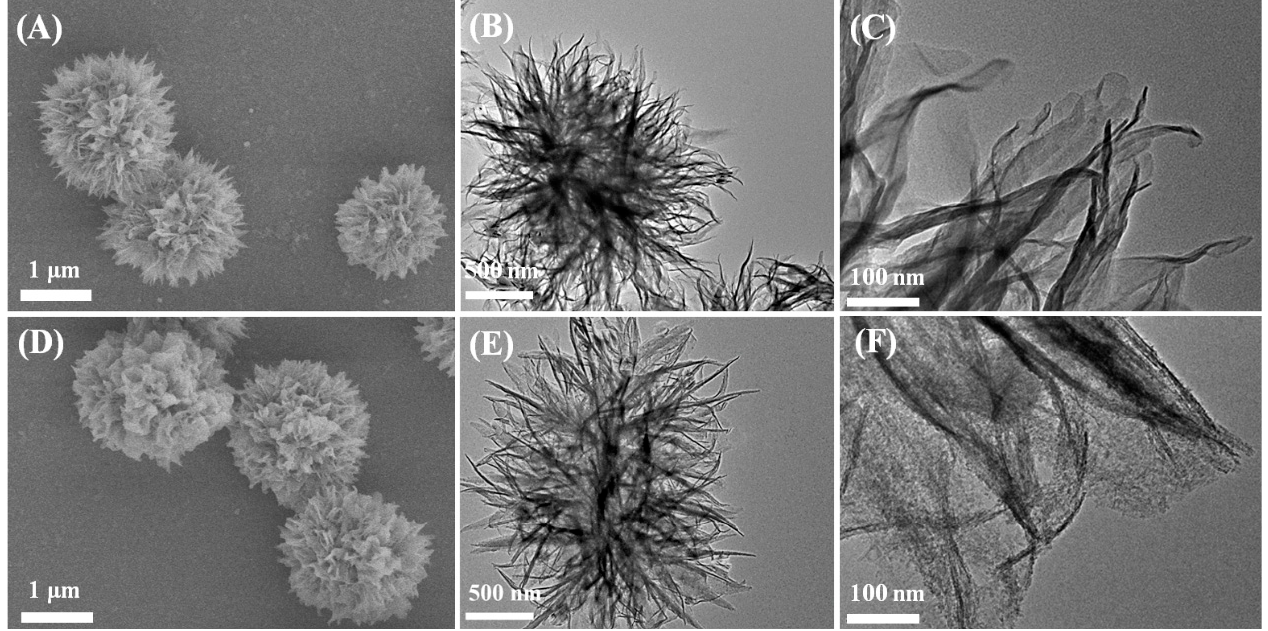
Figure 1. SEM images of Ti(i-OPr) 4 − x /(AcOH) x complex ( A ), and hierarchical Ti-MOF microflowers ( D ). TEM images of Ti(i-OPr) 4 − x /(AcOH) x complex ( B , C ), and hierarchical Ti-MOF microflowers ( E , F ).